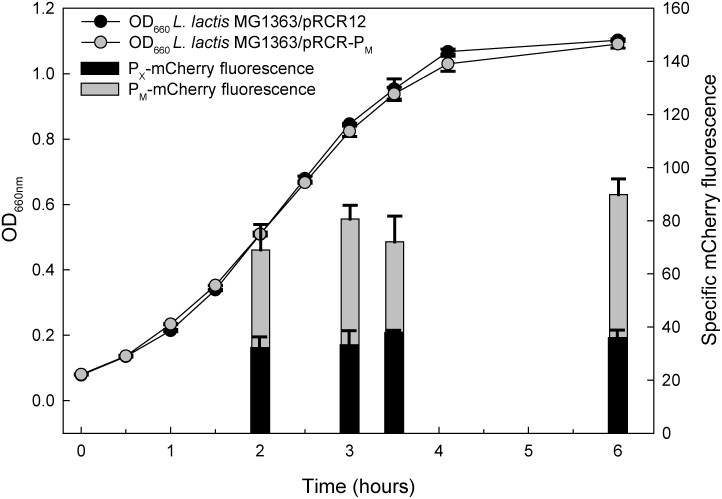
Comparative analysis of the specific fluorescence emitted by lactococcal cells carrying either pRCR12 or pRCR-PM vectors. L. lactis cells harboring either pRCR12 or pRCR-PM were grown in M17G for 6 h, without shaking, and the optical density at 660 nm was measured every 30 min using a Spectronic 20D+. The mCherry fluorescence was measured at the indicated points of the growth curve, once the cells were harvested, washed and resuspended in PBS, and then incubated 4 h at 22°C for completion of FP maturation. Vertical bars represent the specific fluorescence emitted by the lactococcal cells.